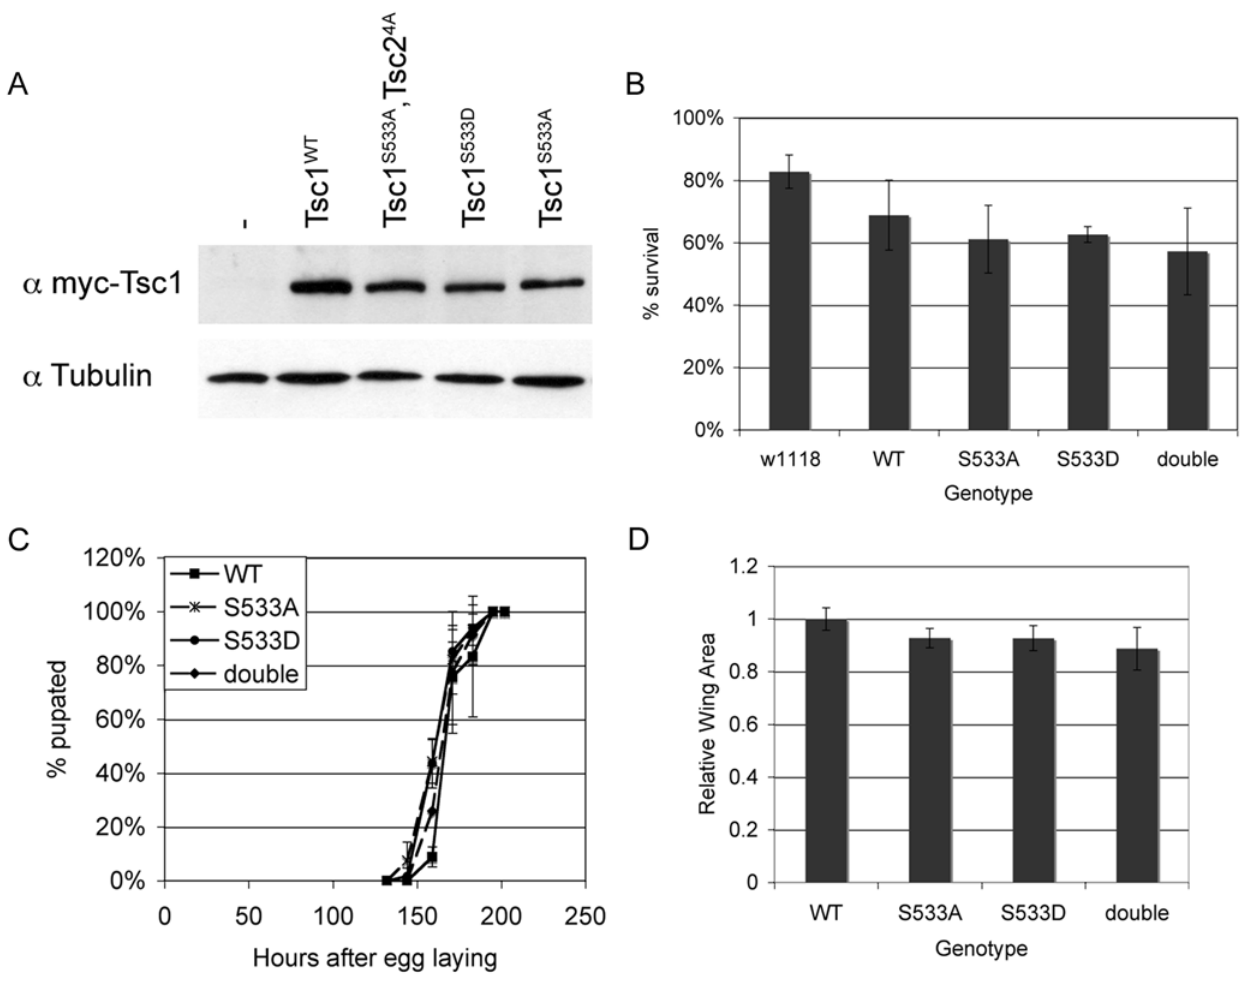
Figure 2. Flies lacking Akt phosphorylation sites on Tsc1 and Tsc2 are viableandnormal in size. (A) Expression levels of myc-Tsc1 in fly lines homozygous for the Tsc1 29 mutation, rescued by ubiquitous expression of Tsc1 WT , Tsc1 S533A or Tsc1 S533D , or flies homozygous for both the Tsc1 29 and Tsc2 192 mutations rescued to viability by ubiquitous expression of both Tsc1 S533A and Tsc2 T437A/S924A/T1054A/T1518A (‘‘Tsc1 S533A ,Tsc2 4A ’’). (B,C,D) Survival rates (B), pupation curves (C) and relative adult wing sizes (D) of animals seeded as L1 larvae under controlled growth conditions for genotypes w 1118 (‘‘w 1118 ’’), Tsc1 29 homozygotes rescued by ubiquitous expression of Tsc1 WT (‘‘WT’’), Tsc1 S533A (‘‘S533A’’) or Tsc1 S533D (‘‘S533D’’), or flies homozygous for both the Tsc1 29 and Tsc2 192 mutations rescued to viability by ubiquitous expression of both Tsc1 S533A and Tsc2 T437A/S924A/T1054A/T1518A